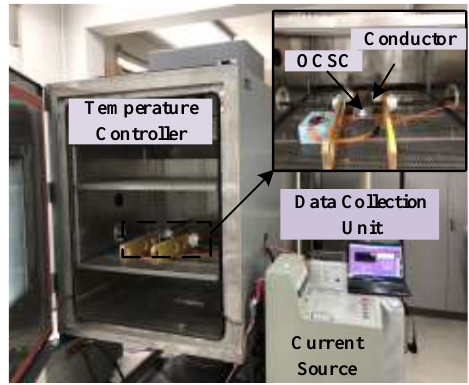
Figure 9. Schematic of temperature experimental setup.